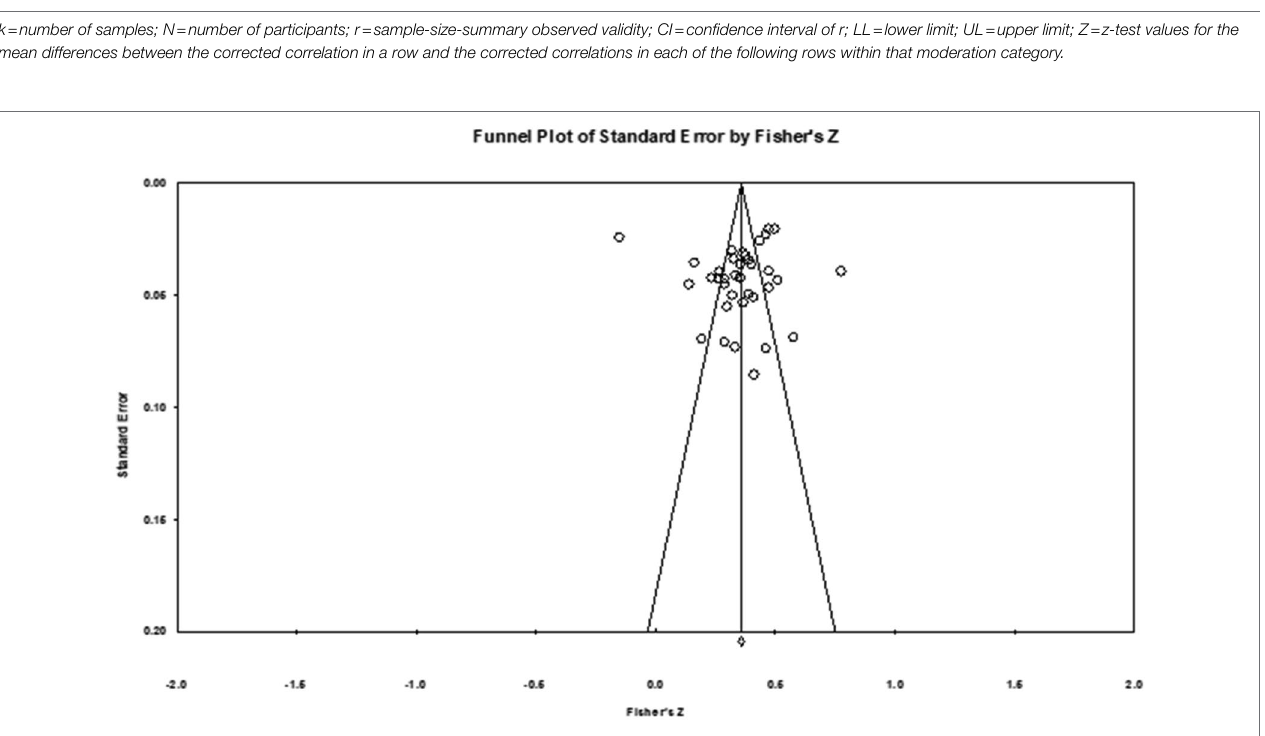
FIGURE 2 | The funnel plots are in this